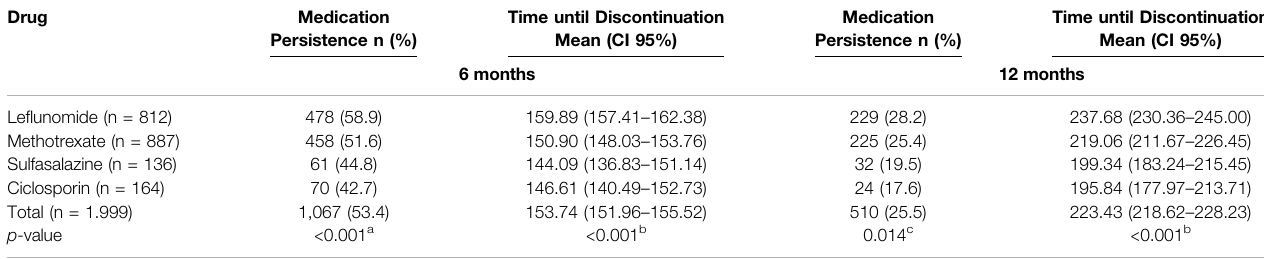
TABLE 2 | Medication persistence at 6 and 12 months of follow-up. Drug